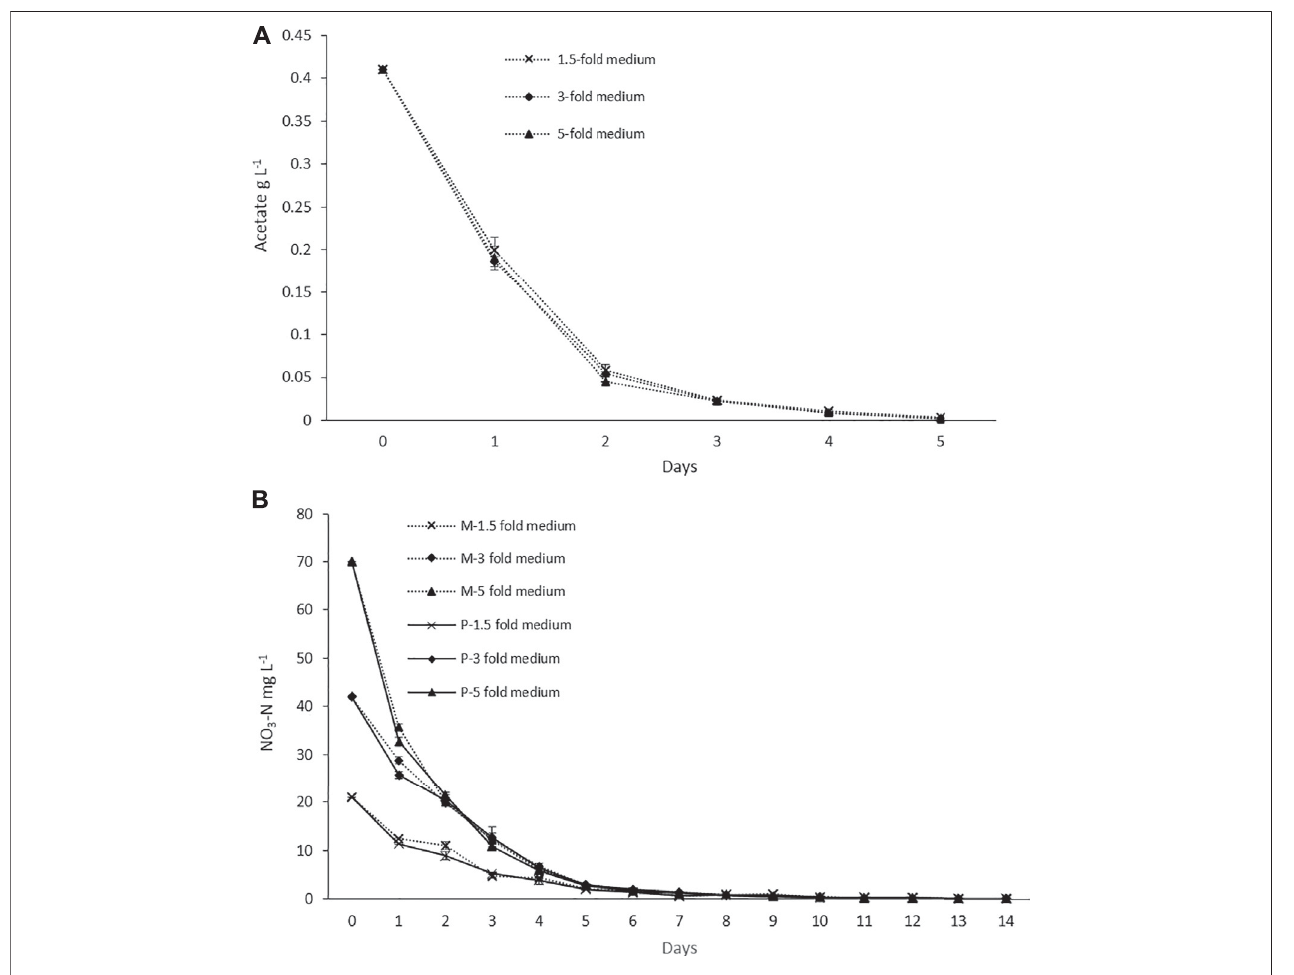
FIGURE 4 | (A) Acetate consumption pro fi les of ORP cultivation with mixotrophic seed cultures. (B) Nitrogen consumption pro fi les of ORP phototrophic (labeled with P) and mixotrophic (labeled with M) cultures.